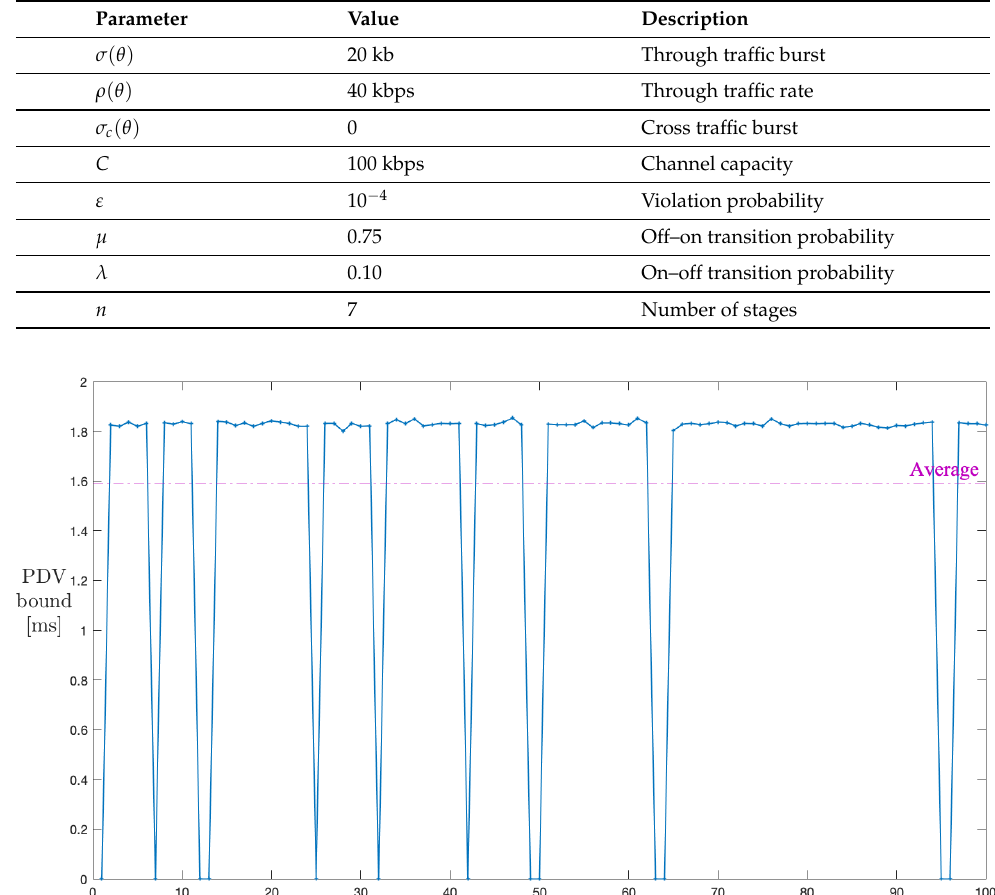
Table 2. Parameters used in time simulation.